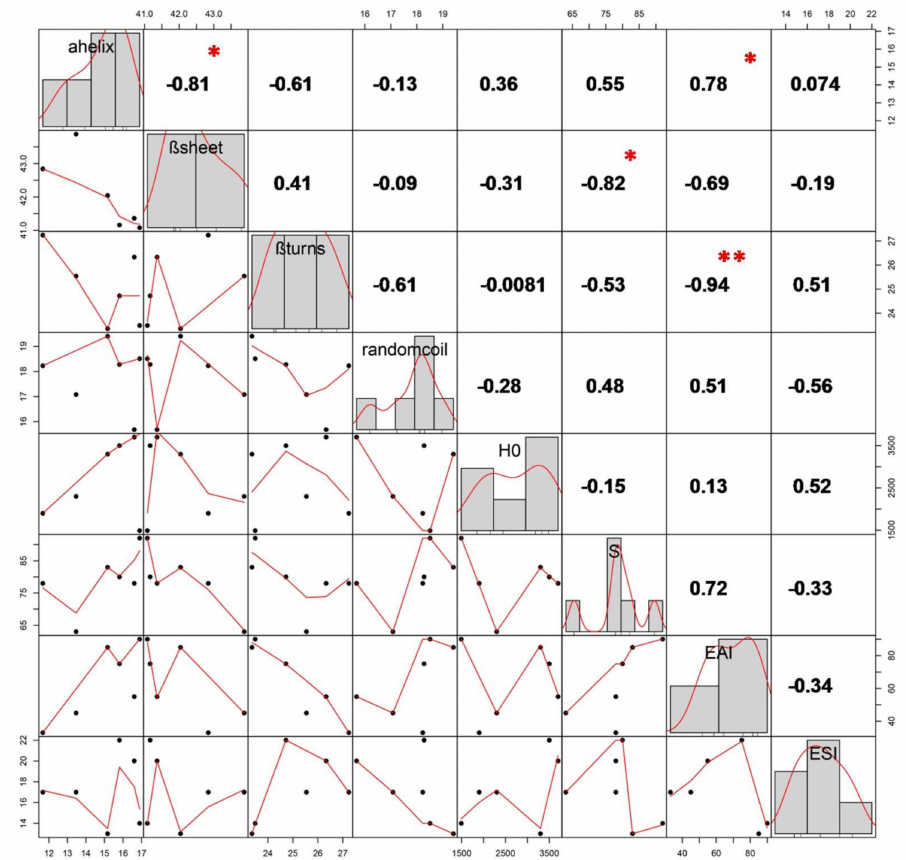
Figure 6. Correlation between the secondary structures composition and functional properties SPI extracted from full-fat soybean flakes powder with and without extrusion treatment. ** and * represent different significance levels at 0, 0.001, and 0.01,